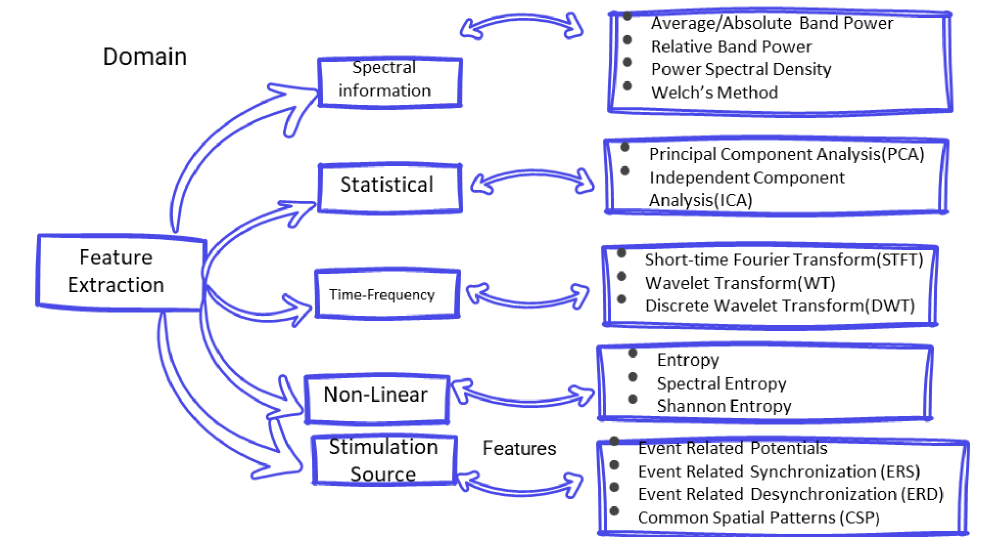
Figure 7. Feature extraction